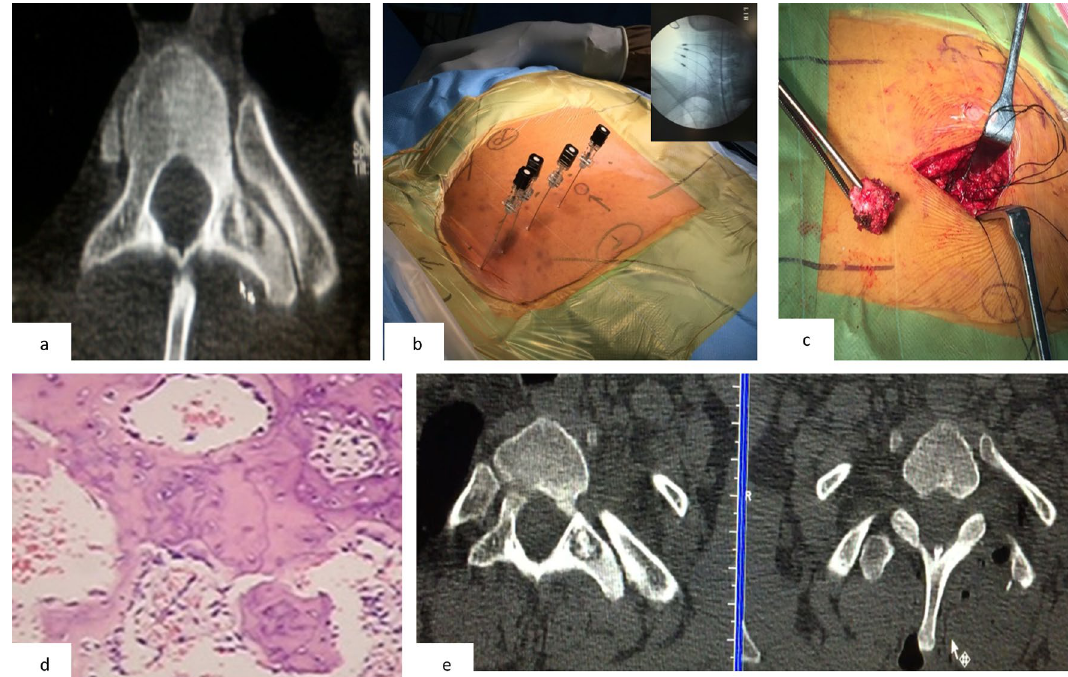
Fig. 2 Case 2 a Axial CT showing D2 vertebral transverse process lytic and central sclerotic lesion, b preoperative CT followed by intraoperative C arm localization of D2 level, c excised tumor mass, d HPE slide confirming osteoblastoma, e pre- and post-operative comparative axial CT cut showing complete removal of